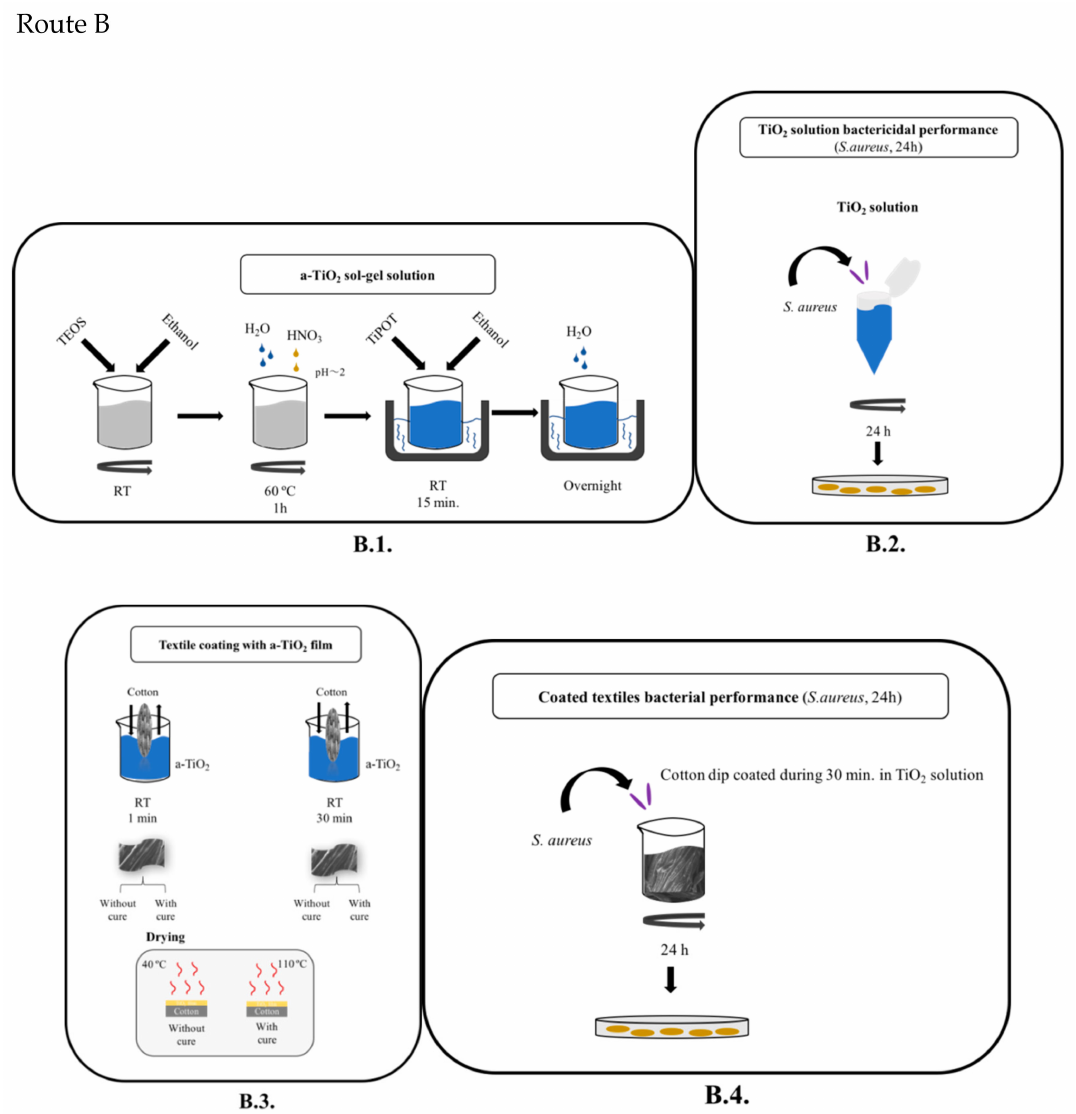
Figure 2. Process flowchart, namely: Route A (sol-gel NPs synthesis and textiles impregnation with NPs) and Route B (sol-gel film synthesis and textiles coating). Note: RT-room temperature; C-chitosan; TEOS-tetraethyl